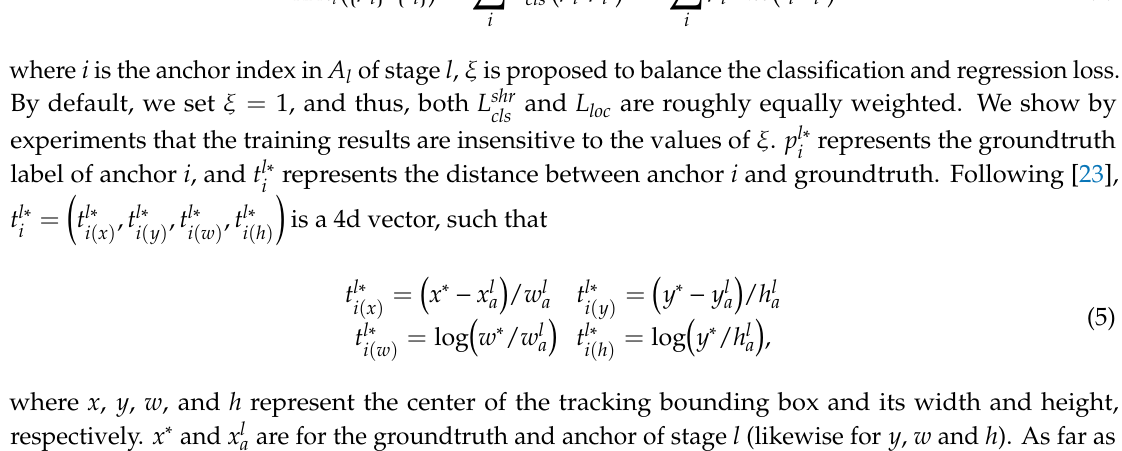
Figure 4. The comparison between the original image, color scores and different-stage response maps. ( a ) Contains the original image and the region of interest, ( b ) illustrates the color scores, and ( c – e ) clearly provide the multi-stage response maps.